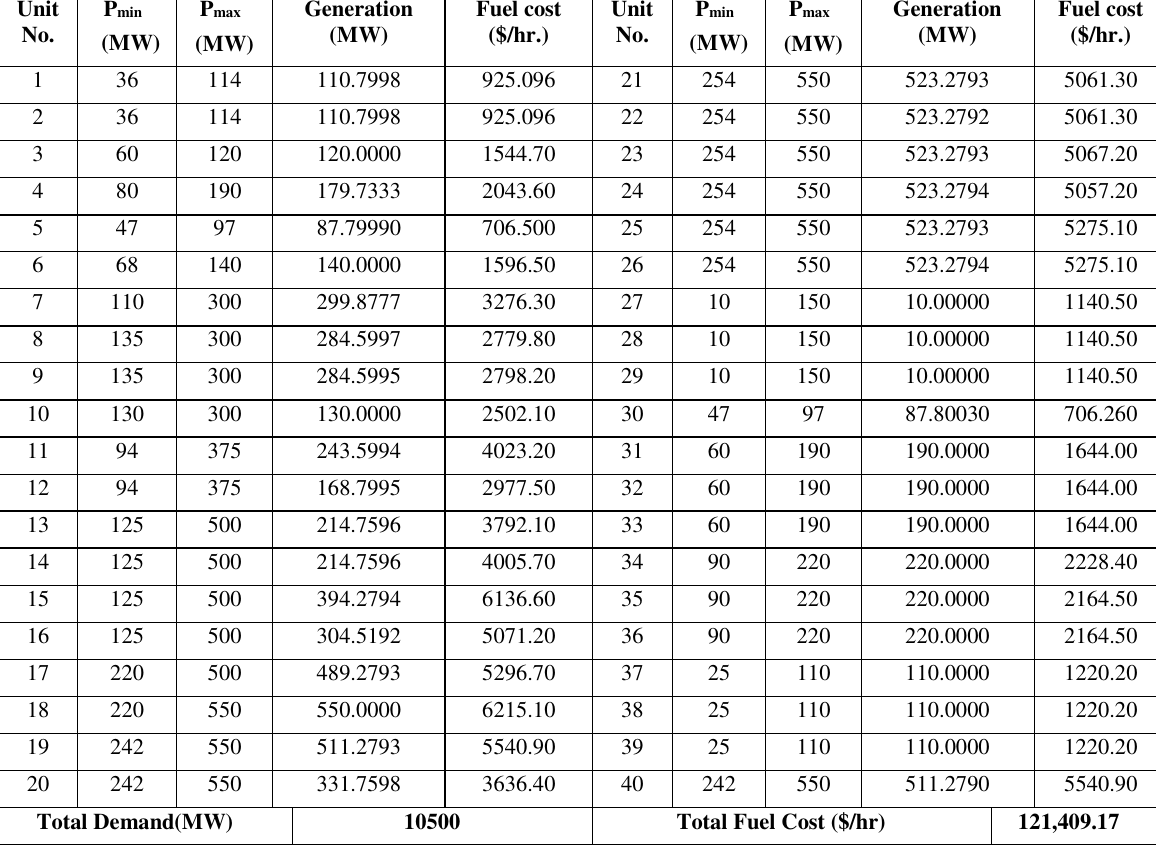
TABLE A4: OPTIMAL GENERATIONS FOR TEST CASE